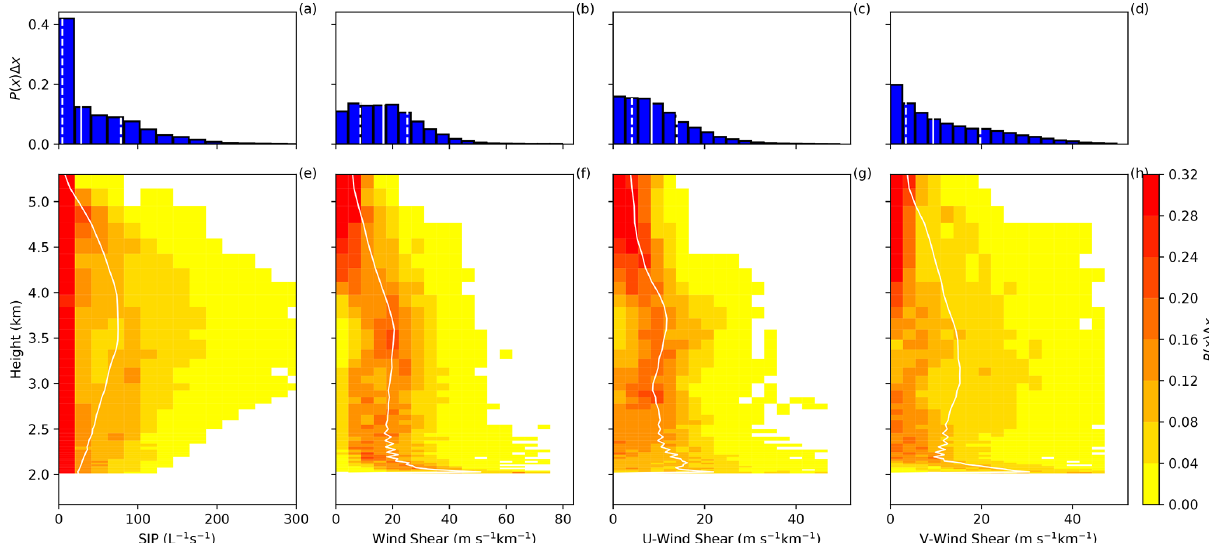
Figure 9. Probability density functions of different variables ( P ( x )) from the BR2.8T simulation from all model levels (top row) and at each model level (bottom row) for (a, e) secondary ice production (SIP) rate, (b, f) wind shear, (c, g) U-wind shear and (d, h) V-wind shear between 14:30–15:45UTC. The solid and dashed white lines are the horizontal 50th percentile and the 25th and 75th percentiles, respectively, of each variable over the 10km × 10km